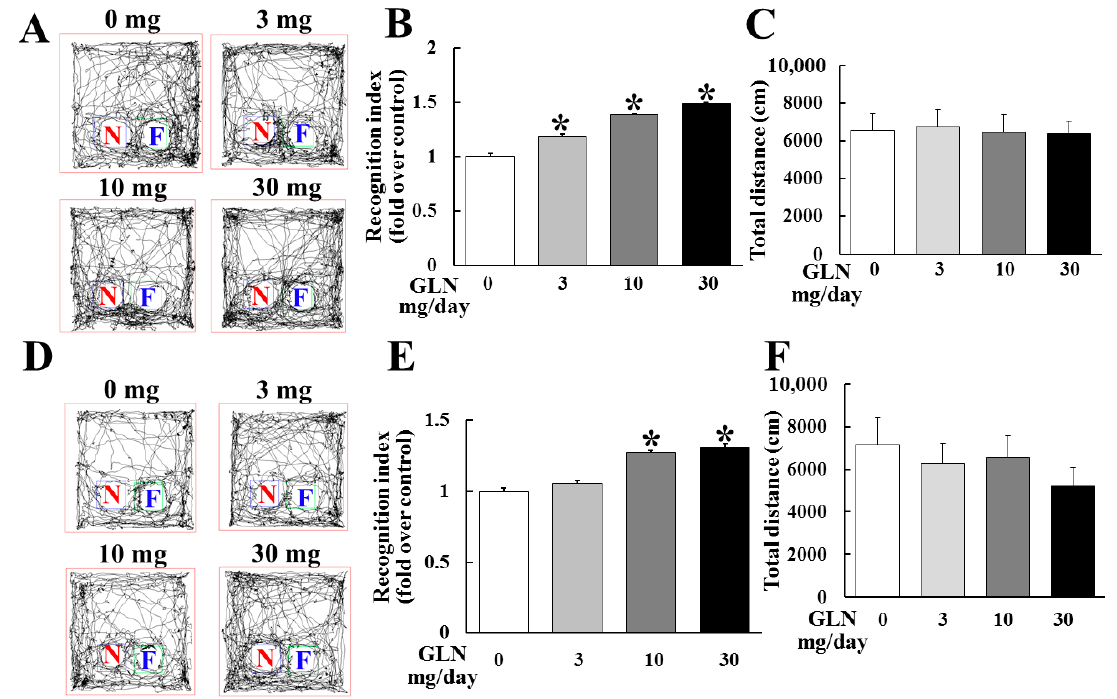
Figure 1. GLN enhancement of animal cognitive performance. The C57BL / 6 male mice received a daily intraperitoneal (IP) GLN injection (0, 3, 10 and 30 mg / mouse) for 7 ( A – C ) or 14 days ( D – F ), followed by the novel object recognition test (NORT). A set of objects with a previously presented familiar object ( F ) and a new novel object (N) were presented to the trained animals. The moving tracks of the animals were recorded ( A , D ). The recognition index ( B , E ) and total moving distance ( C , F ) were determined. The results represent the means ± S.D. ( n = 8) *, p < 0.05, compared with the 0 mg group.